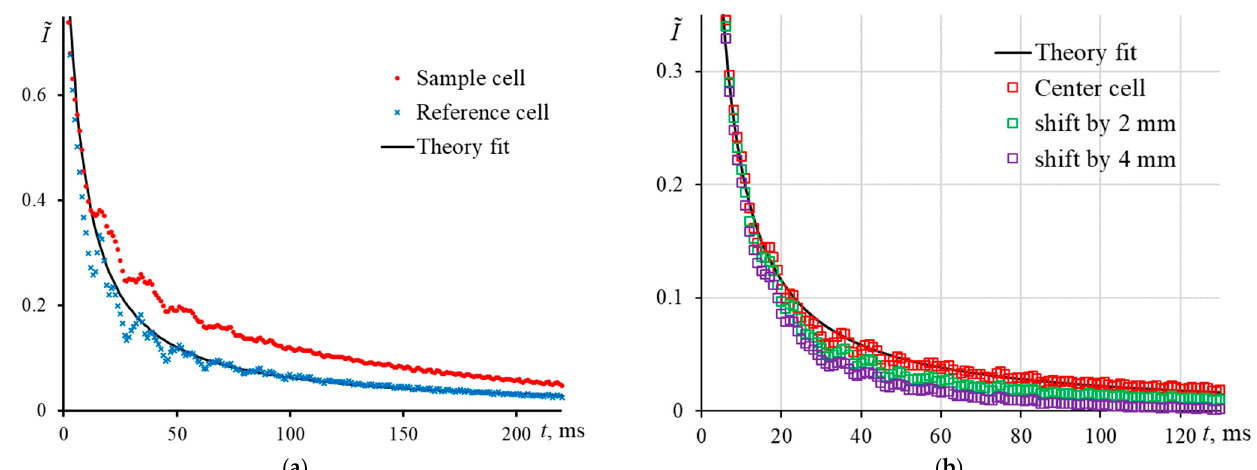
Figure 9. Normalized transient curves for a solution of Sudan I in ethanol (0.1 µmol/L): ( а ) 10.0 mm reference and 5.0 mm sample cells for mispositioning of 2.5 mm relative to the excitation beam waist; ( b ) a 10.0 mm sample cell for mispositioning of 2 and 4 mm relative to the excitation beam waist; middle-focused configuration ( 𝜔 (cid:3032)(cid:2868) = 42 µm, Figure 2, Table 3).